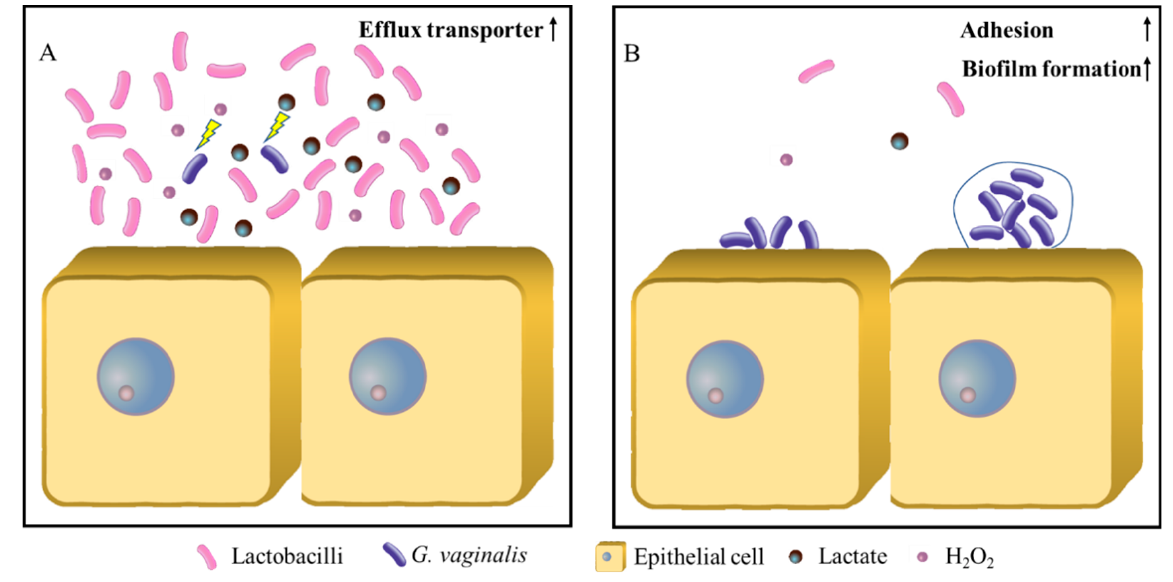
Figure 3. The effect model of the lactobacilli on the biofilm formation of G. vaginalis . ( A ) Healthy vaginal microecosystem; ( B ) BV vaginal